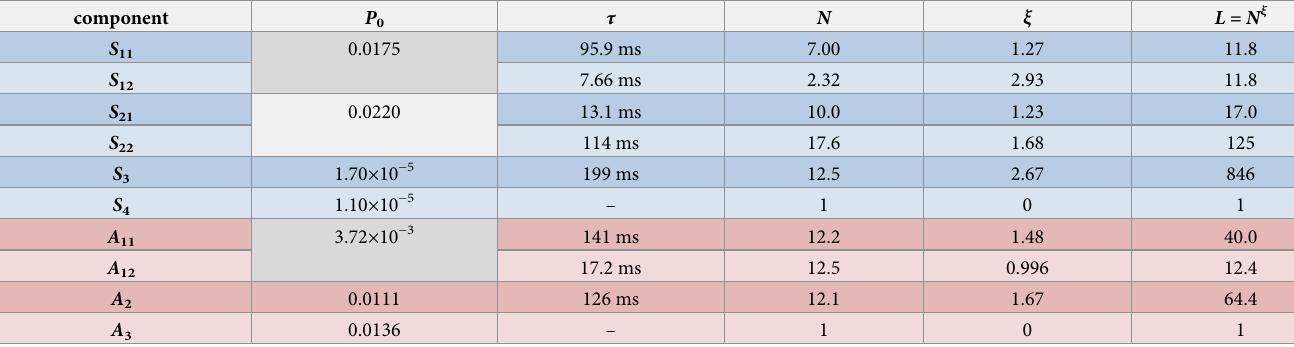
Table 3. Metaparameters for Facilitation of Release Fidelity.